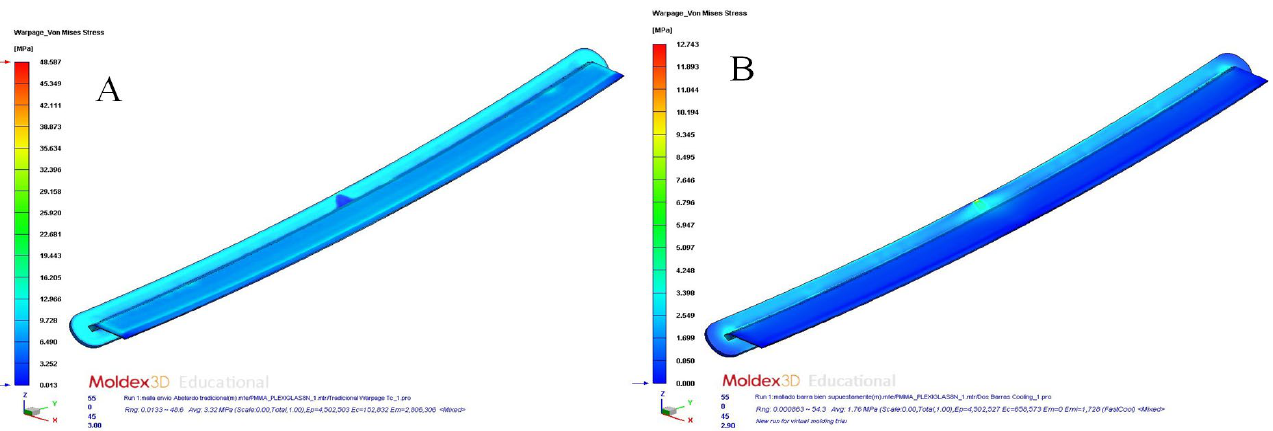
Figure 18. Total warpage (mm); conformal channels—dashed Fastcool bars ( A ), conformal channels ( B ).